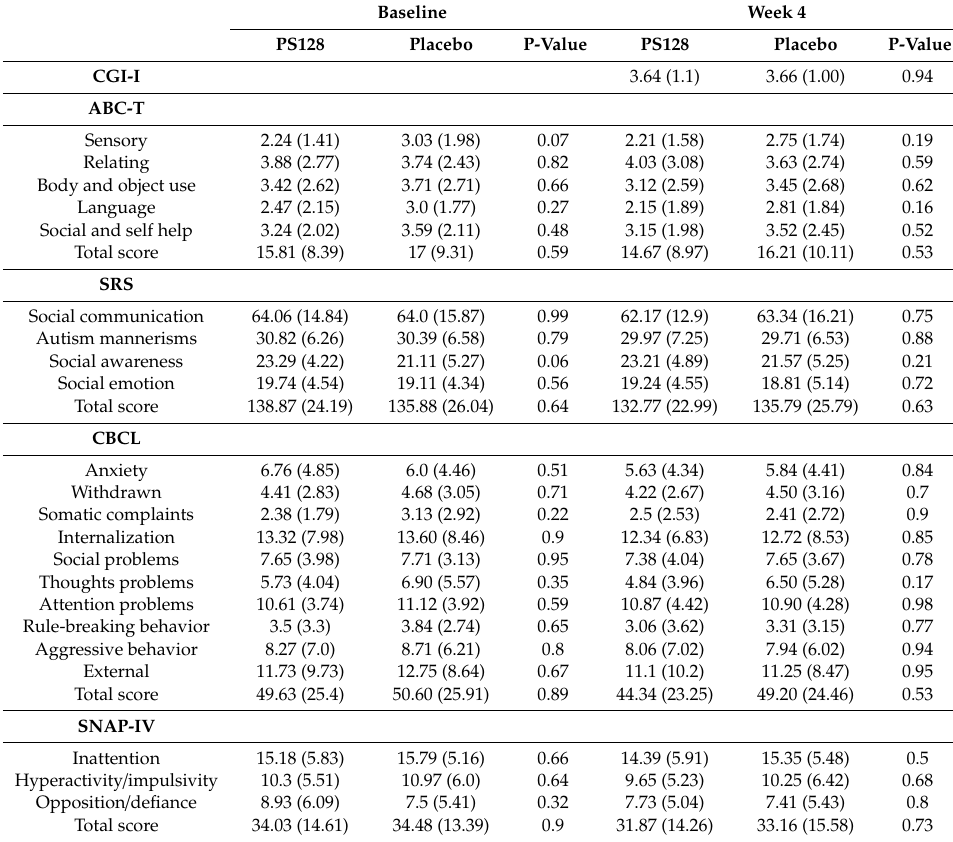
Table 2. Analysis of clinical